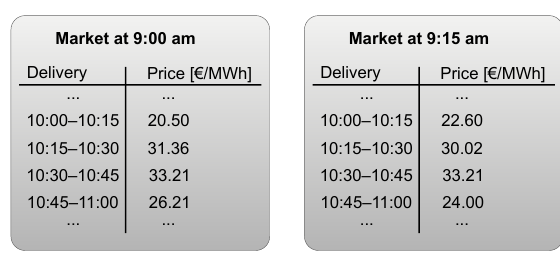
Figure 1. Illustration of the (simplified) workings of the intraday electricity